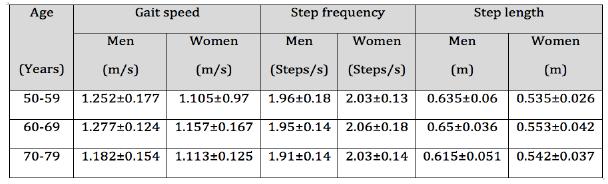
Figure 7: Referenced norms.